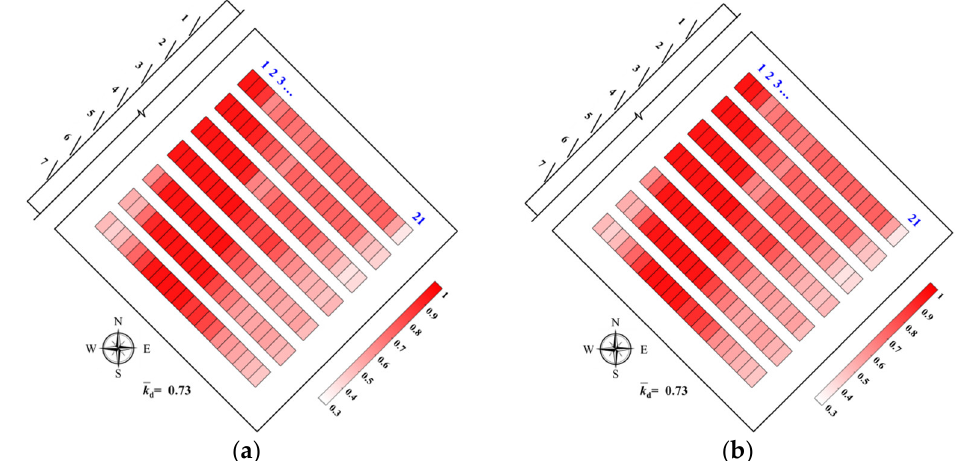
Figure 13. Distributions of directionality factor k d on solar arrays with building orientation α = 45° at different locations: ( a ) Jinan, China; ( b ) Beijing, China.